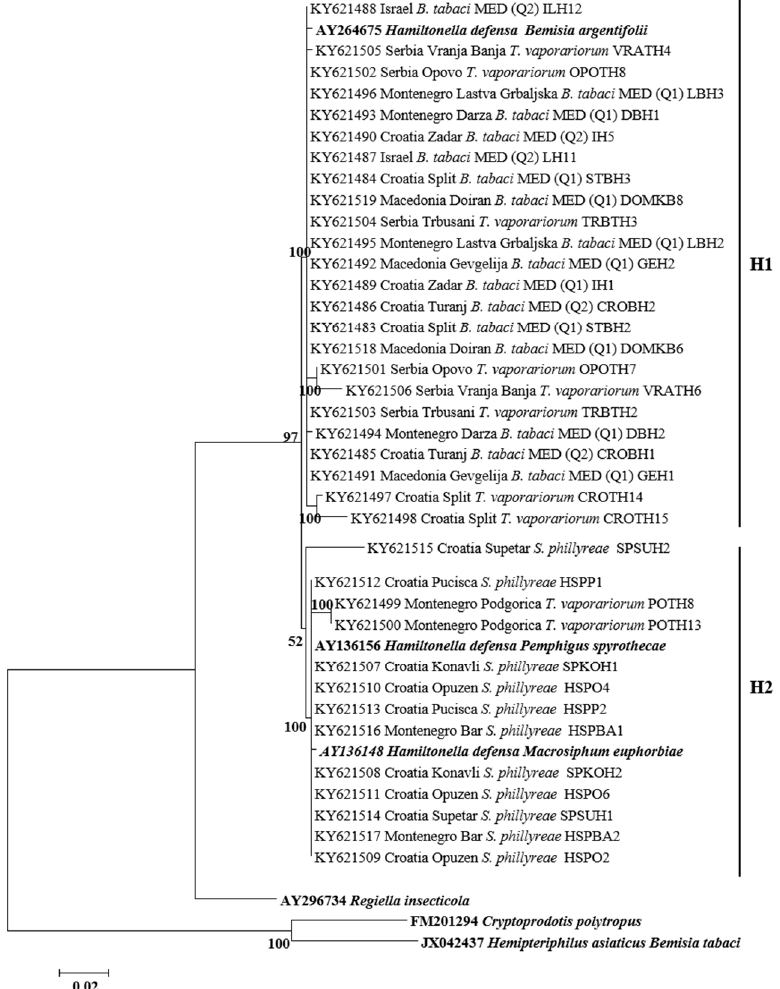
Figure 3. Molecular phylogenetic placements of Hamiltonella from whitefly species. The tree was constructed via Bayesian inference (BI) using an HKY substitution model. Sequences from GenBank are indicated in bold, while those obtained in this study are rearranged based on geographical origin and associated whitefly hosts, B. tabaci , T. vaporariorum , and S. phillyreae .